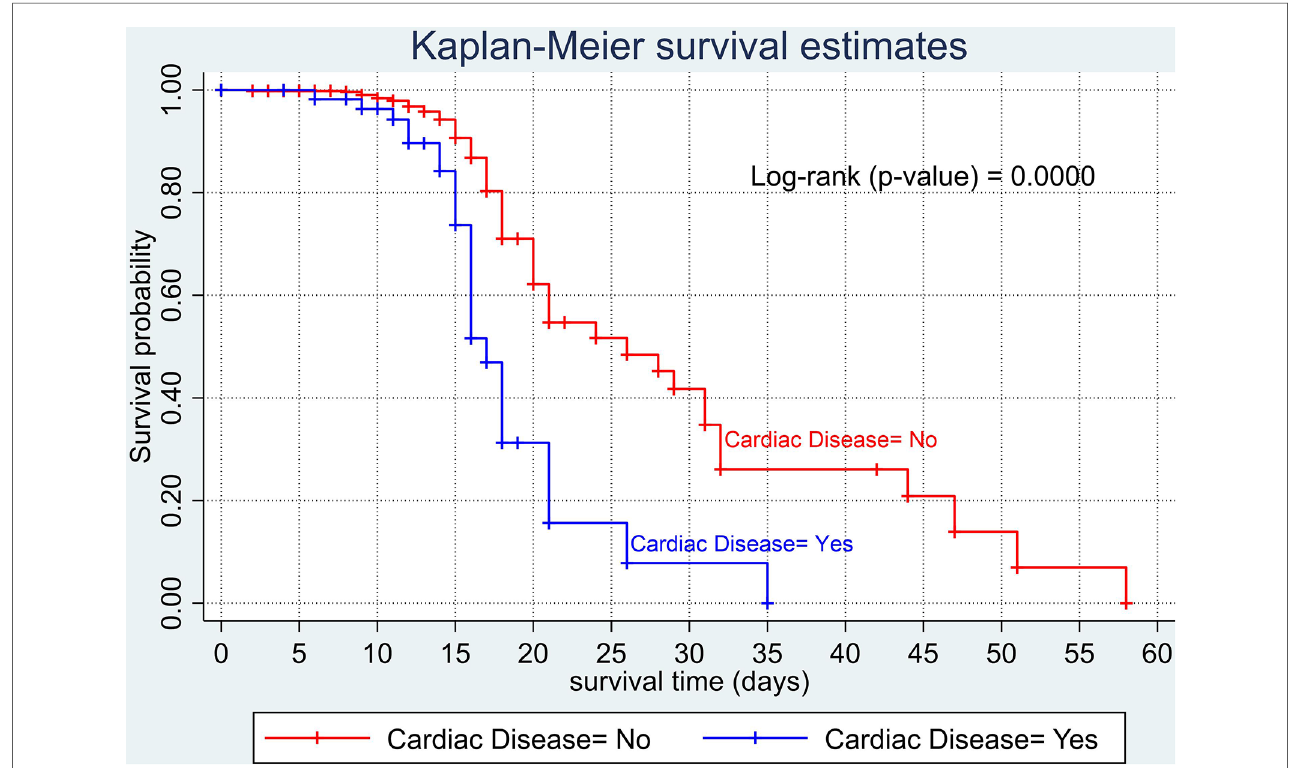
FIGURE 5 Kaplan – Meier survival curve based on the presence of cardiac disease (heart failure) among adult COVID-19 patients.